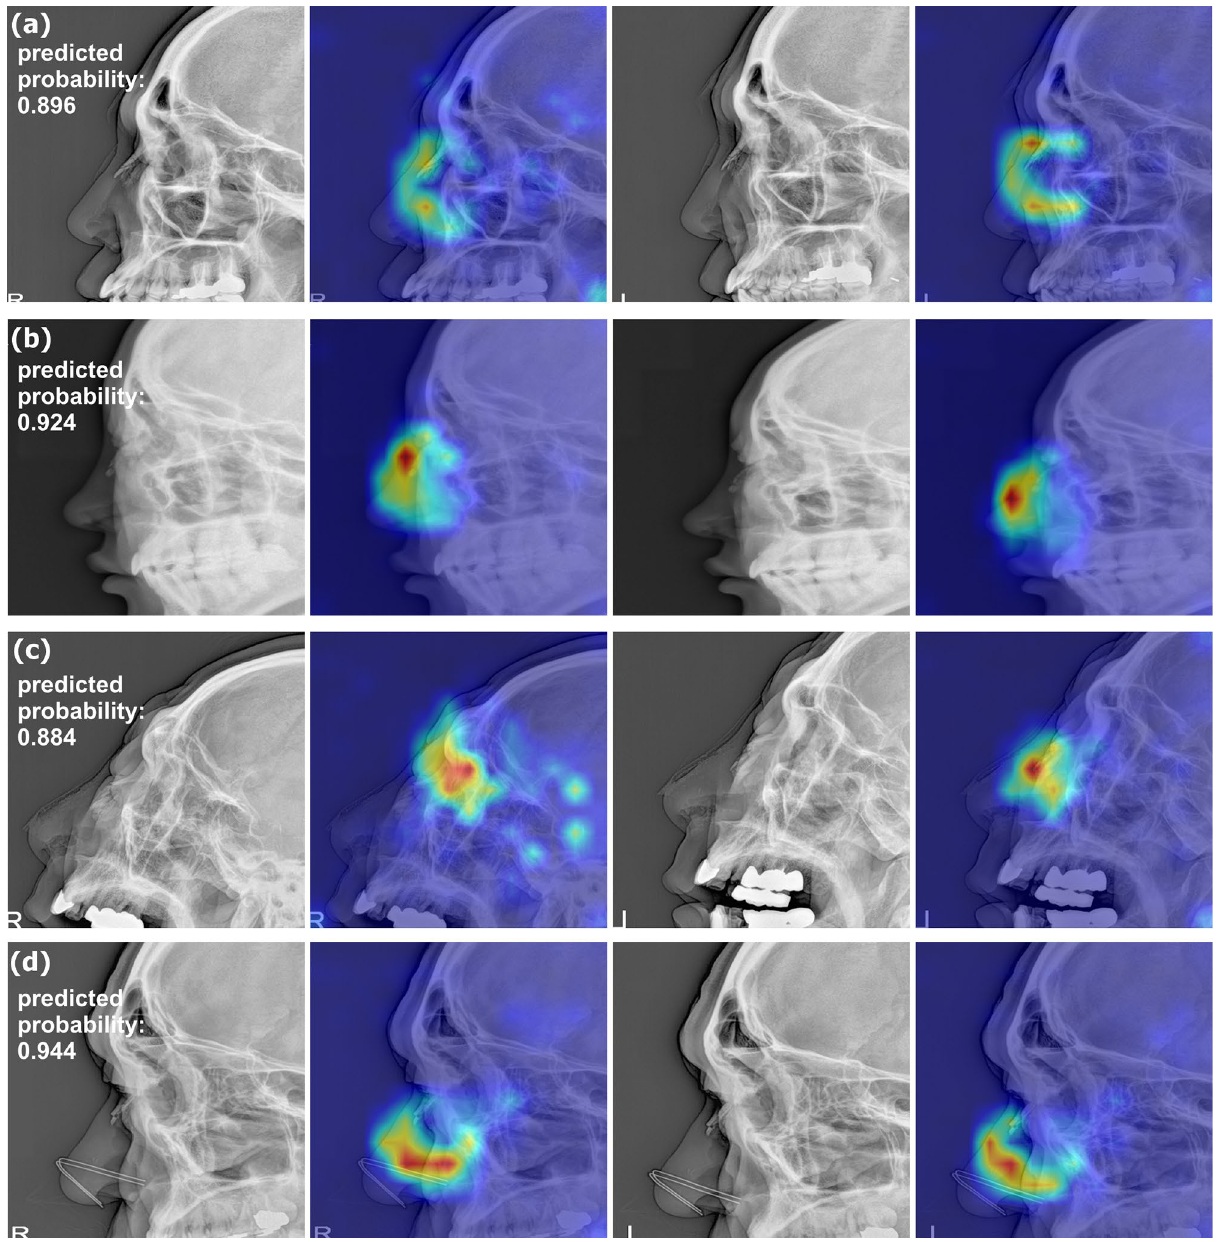
Figure 2. Example images of bilateral nasal bone radiographs overlaid with Grad-CAM heatmaps. The DL model and radiologists all correctly identified the nasal bone fractures. The images ( a ) and ( b ) show typical nasal bone fractures with fracture lines; images ( c ) and ( d ) show comminuted fractures with skin folds ( c ) and a metallic nose wire from a facial mask ( d ). The predicted probabilities of fractures by the DL model are shown for each